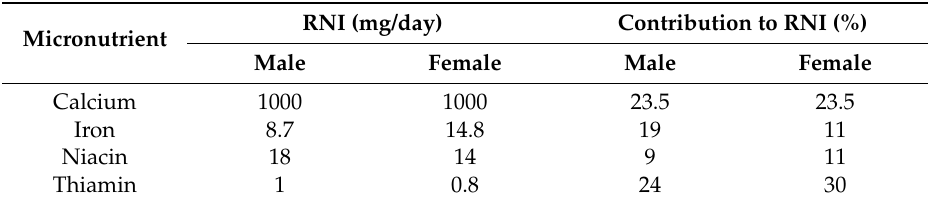
Table 2. Reference nutrient intake (RNI) for calcium, iron, niacin and thiamin and the contribution of 100 g of standard